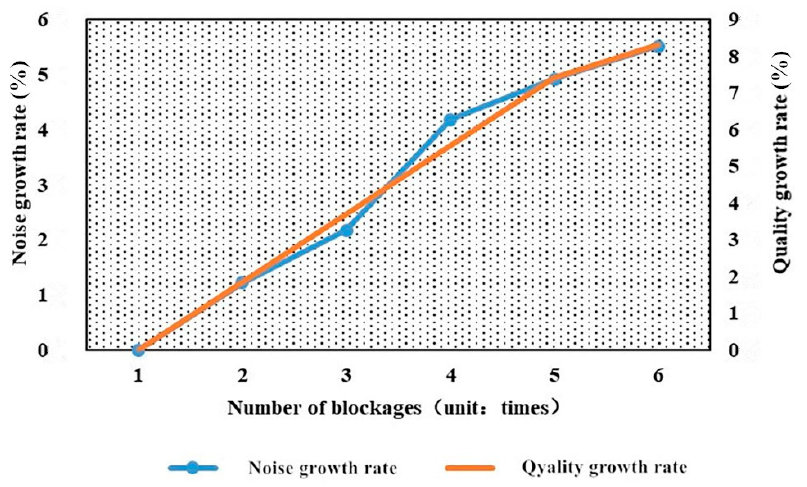
Figure 13. Noise growth rate and quality growth rate.